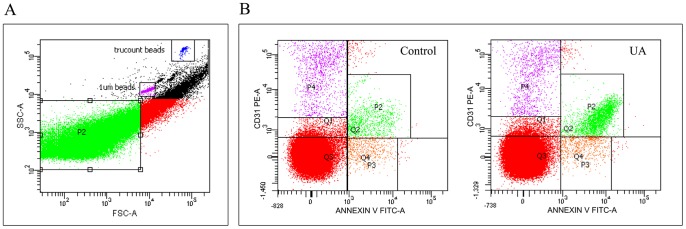
Characterization of microparticles (MPs) from plasma of control and UA patients by flow cytometry.(A) Trucount beads and calibrator beads (1 µm in diameter) were gated in the upper two windows respectively. MPs are particles with size between 0.1 and 1 µm and gated in window P2. (B) Representative flow cytometry plot displaying MPs from the plasma of controls and UA patients stained with AnnexinV-FITC and anti-CD31-phycoerythrin. Annexin V+ CD31+ MPs were gated in window P2.